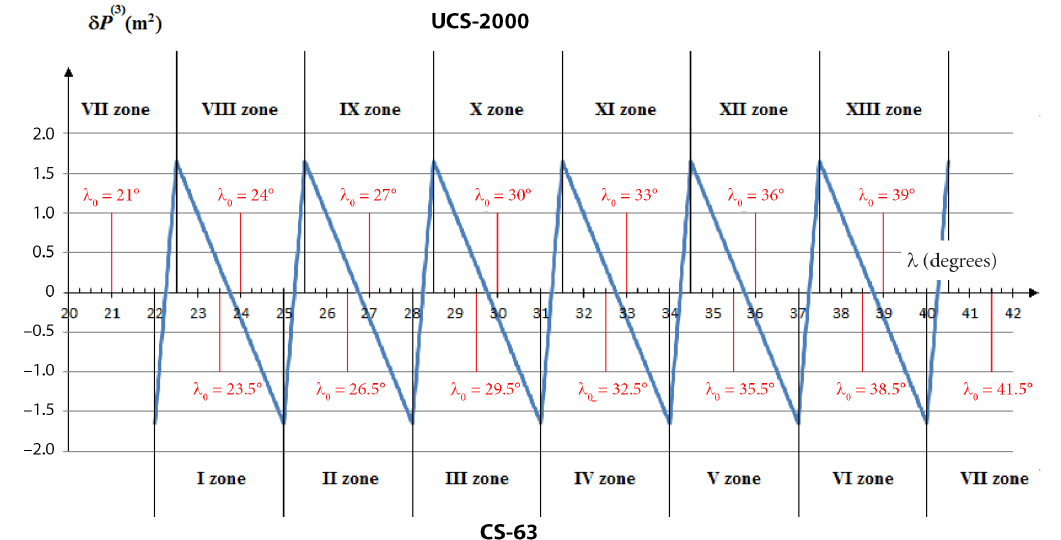
Figure 2. Graph of change δ (3) P depending on longitude along the parallel with latitude 49 ϕ = ° for a parcel of 1 hectare in the CS-63